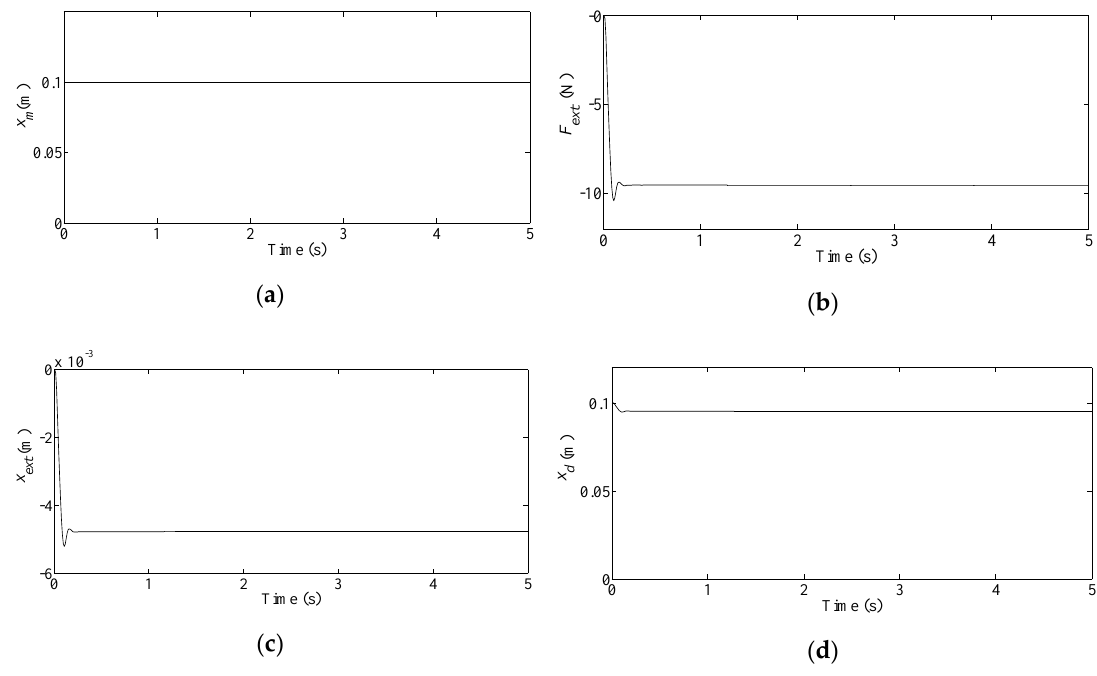
Figure 3. Admittance control variables pertaining to step tracking: ( a ) primary desired trajectory provided by the master manipulator, x m ; ( b ) external force, F ext ; ( c ) displacement corresponding to the external force, x ext ; ( d ) desired trajectory achieved from admittance model, x d